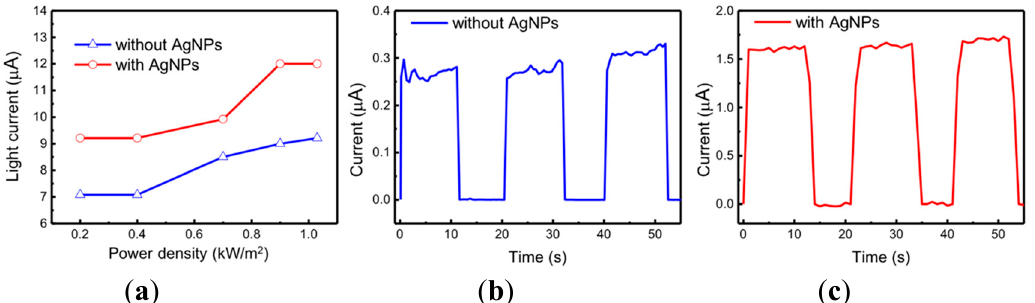
Figure 7. ( a ) Light current as a function of the input light power density under solar simulator illumination for photodetectors with and without Ag nanoparticles at the bias voltage of –2 V. Time-dependent current of photosensors ( b ) without and ( c ) with Ag nanoparticles recorded at the bias voltage 2 V under AM1.5G solar simulator illumination, turning on and off.